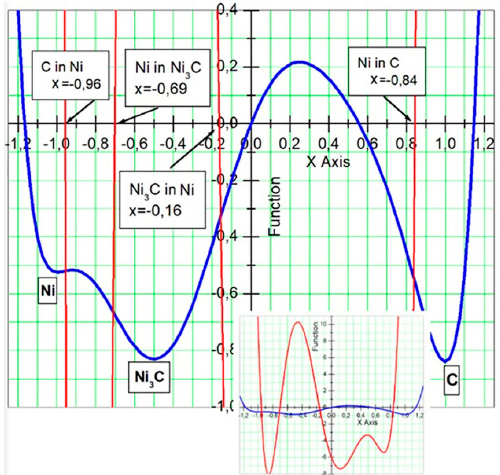
Figure 4. Plot of function f ( ϕ ) (blue line) Equation (6) and its second derivative (red line). Included are full curve of second derivative (red curve) of function f( ϕ ) and function itself (blue curve). Three di ff erent phases, which correspond to three minimum points of function f ( ϕ ) , are shown. The solubilities of di ff erent phases, which related to the inflection points of function f ( ϕ ) or with zero values of second derivative, are indicated.